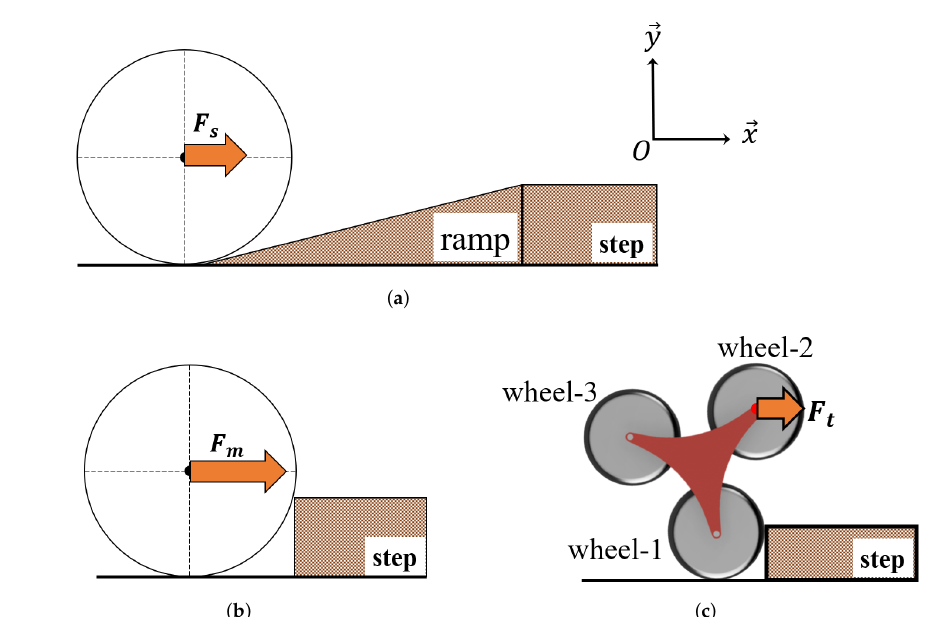
Figure 2. Three cases to be employed during step ascending: ( a ) using ramp, ( b ) using actuators, ( c ) using three-wheel